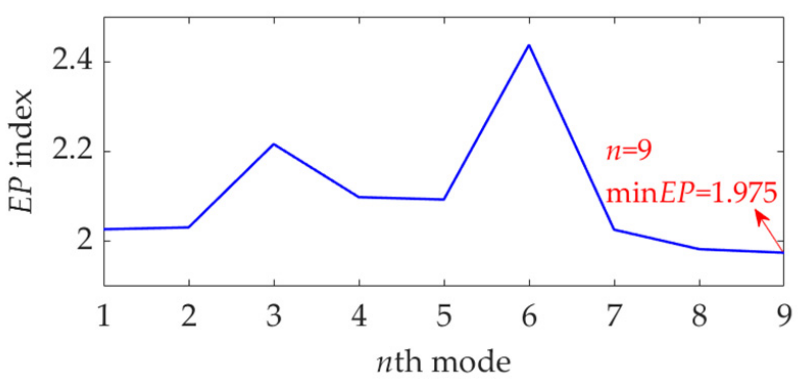
Figure 14. The EP index of each mode.